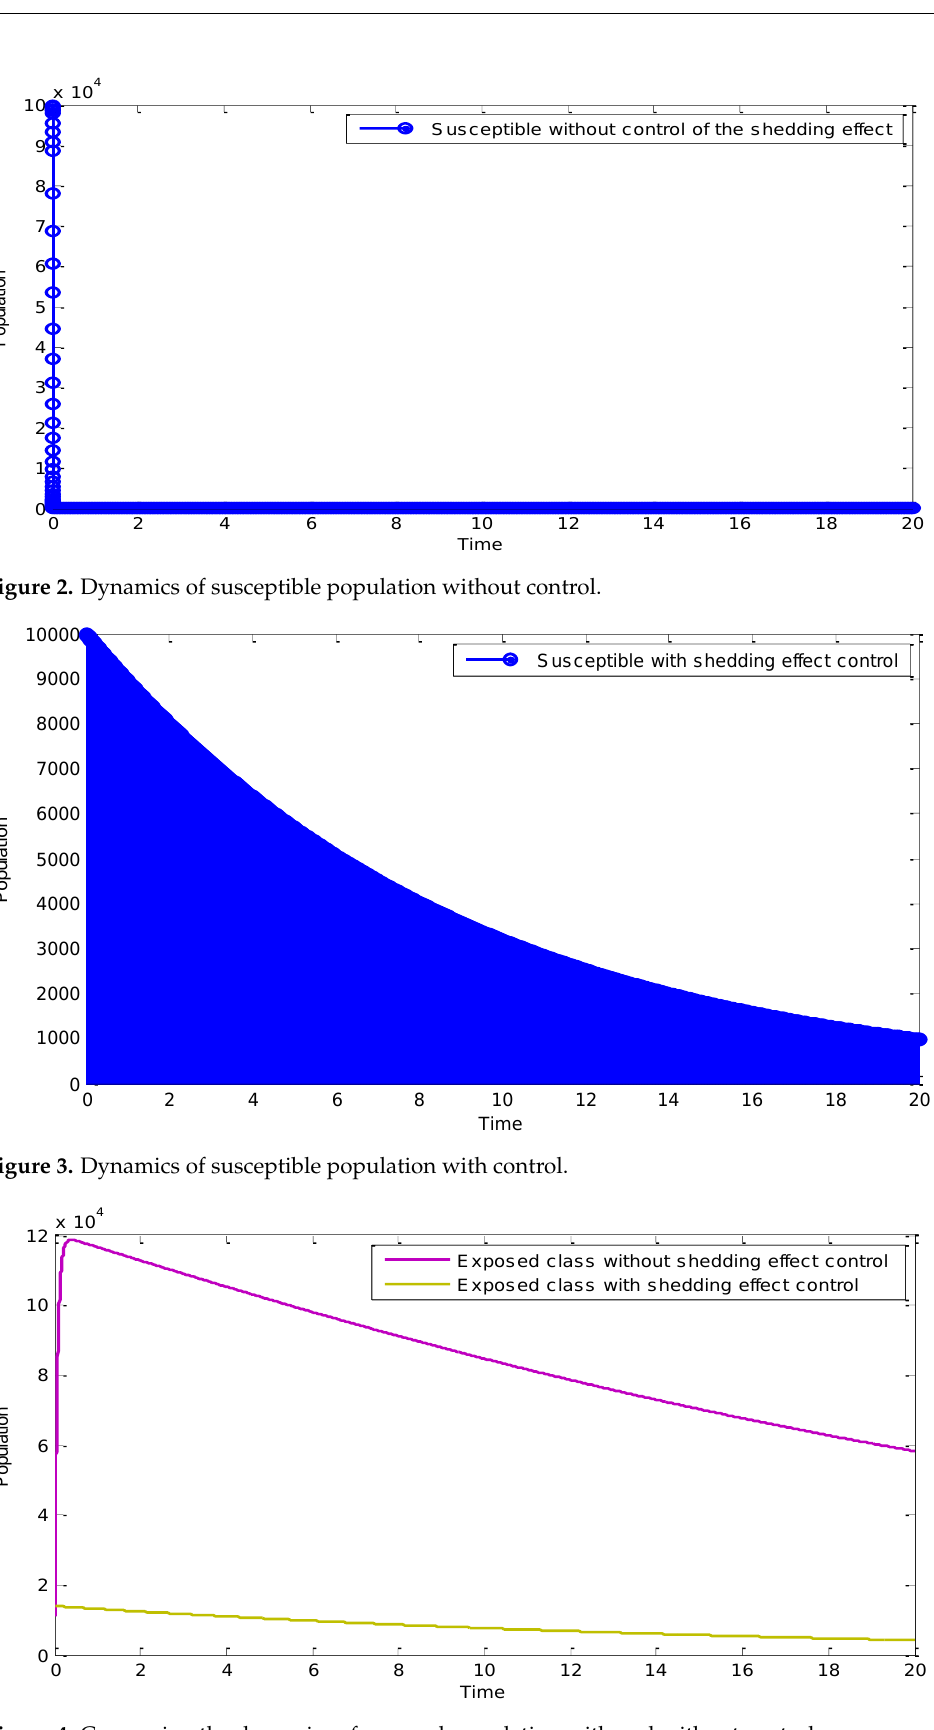
Figure 4. Comparing the dynamics of exposed population with and without control.